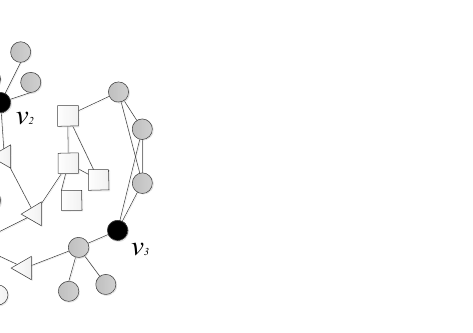
Figure 1. A toy example of social influence. The seed nodes are v 1 , v 2 , v 3 , represented in black, and the nodes influenced by the seed nodes are in